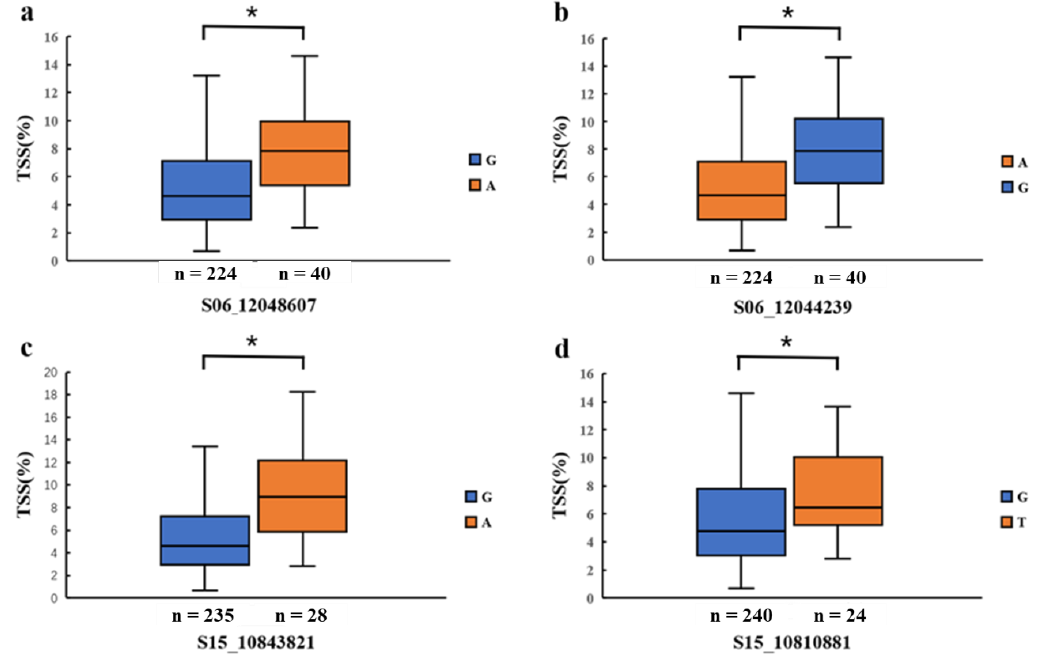
Figure 4. Comparison of the total soluble sugar in accessions with different alleles of four significant SNPs by boxplot. ( a – d ) The boxplot of S06 12048067, S06 12044923, S15 110843821, and S15 10180881. n , the number of soybean accessions. *, p < 0.05.